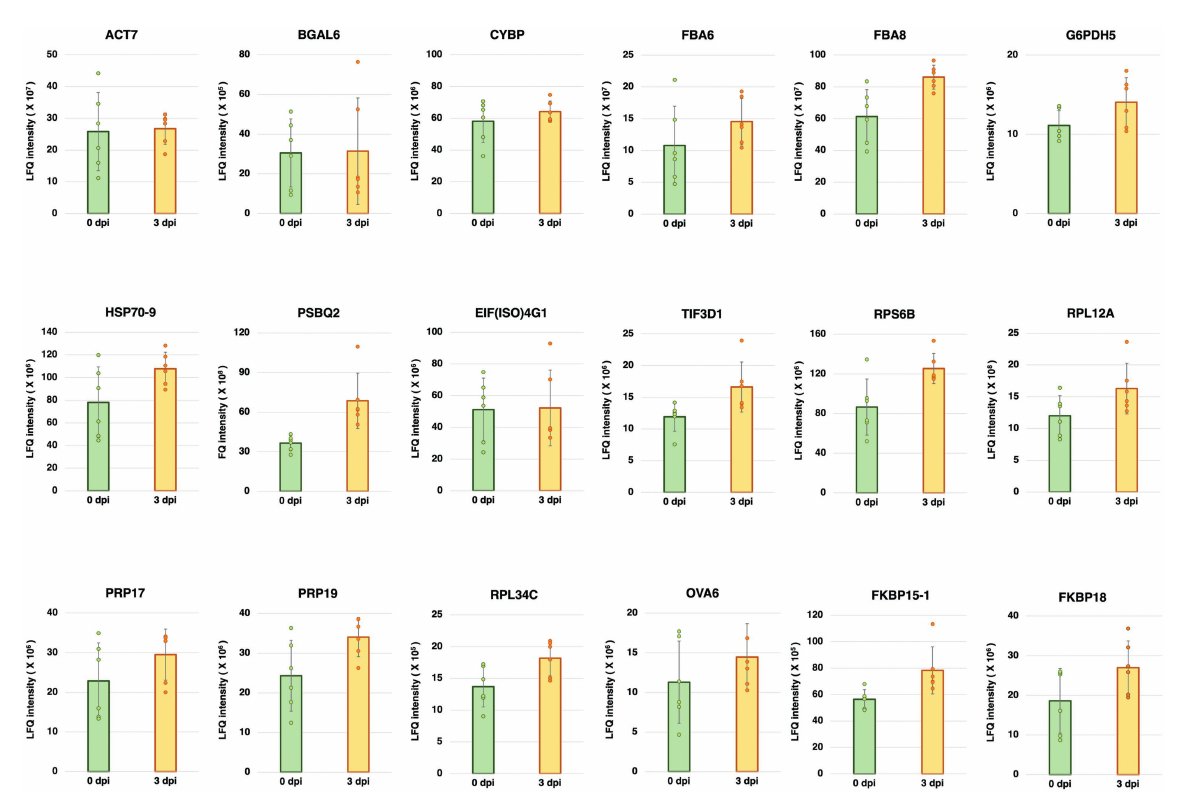
FIGURE 1 Label-free quantification (LFQ) intensities of the candidate reference genes having stable abundances between 0 and 3 days post-inoculation (dpi) with Pseudomonas syringae pv. tomato DC3000 ( Pst DC3000) in 5-week-old A. thaliana ecotype Col-0. The protein abundance levels of these candidate reference genes, calculated from LFQ using Proteome Discoverer v2.4 (Thermo Fisher Scientific, Waltham, MA, United States), were not statistically different between 0 and 3 dpi ( p > 0.05). Three individual plants were pooled as one biological replicate, each with two technical repeats of LFQ analysis. Error bar represents the standard deviation of a total of six technical repeats based on three biological